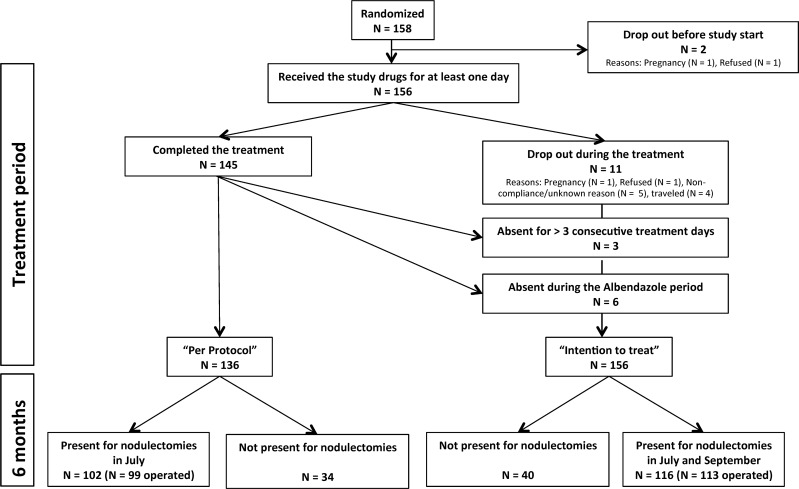
Flow chart of volunteers who took part in the study.